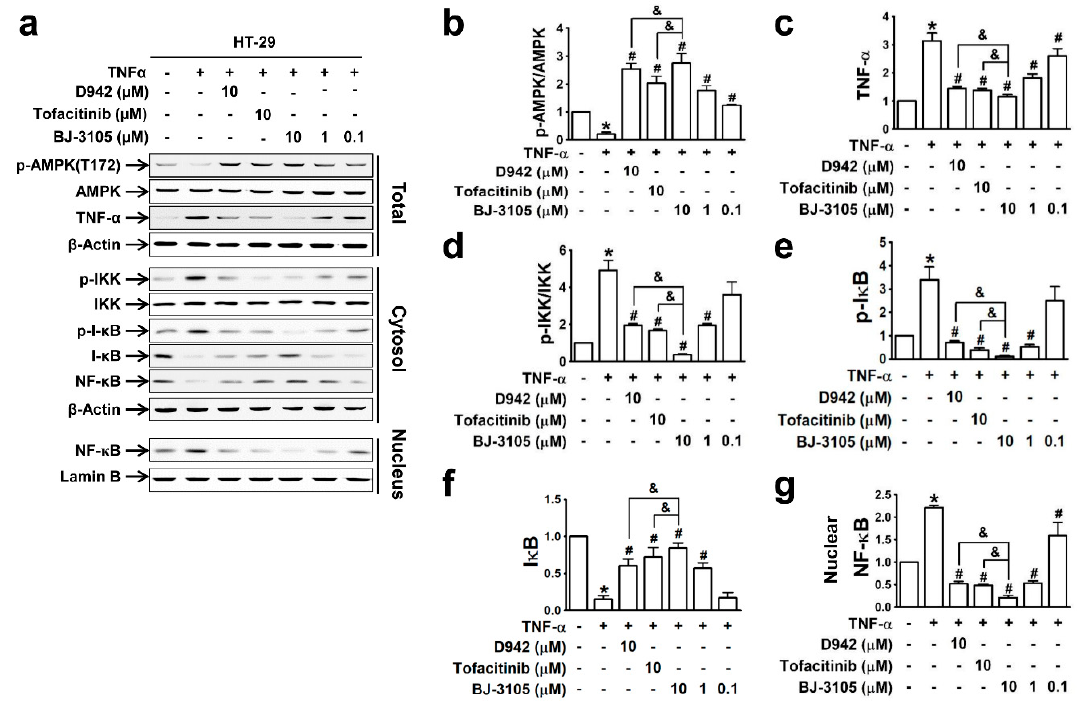
Figure 4. Inhibitory e ff ects of BJ-3105, tofacitinib and D-942 on TNF- α -induced changes in the phosphorylation of AMPK, IKK, I- κ B, and nuclear translocation of NF- κ B in HT-29 cells. Immunoblots ( a ) and quantitation of expression levels of AMPK ( b ), TNF- α ( c ), p-IKK ( d ), p-I- κ B ( e ), I- κ B ( f ) and nuclear NF- κ B ( g ). * p < 0.05, versus the vehicle-treated control group. # p < 0.05, versus the TNF- α -treated group. & p < 0.05, versus the tofacitinib-treated